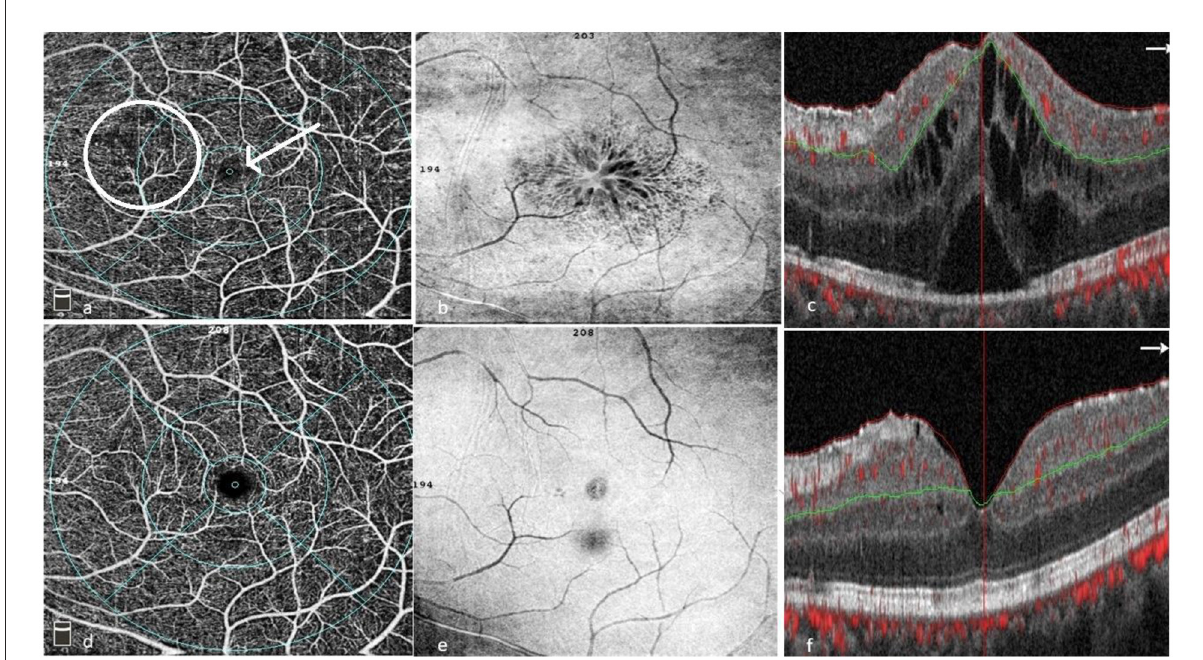
FIGURE6 Patient with BU pre- (a–c) and post treatment (d–f) . (a) OCTA of the superficial capillary plexus showing areas of capillary drop outs, capillary telangiectasia, disorganization and hyporeflective areas corresponding to the cystoid spaces on SD-OCT. (b) En face OCT showing cystoid spaces involving the fovea. (c) SD-OCT with center involving cystoid spaces, subfoveal neurosensory detachment and a hyperreflective epiretinal membrane. (d) OCTA showing resolution of most capillary changes (telangiectasia, drop outs, and disorganization). (e) En face showing resolution of cystoid changes with residual epiretinal membrane. (f) SD-OCT showing resolution of cystoid changes and neurosensory detachment with residual diffuse edema and an epiretinal membrane (Images courtesy of Dr. Wassef A,